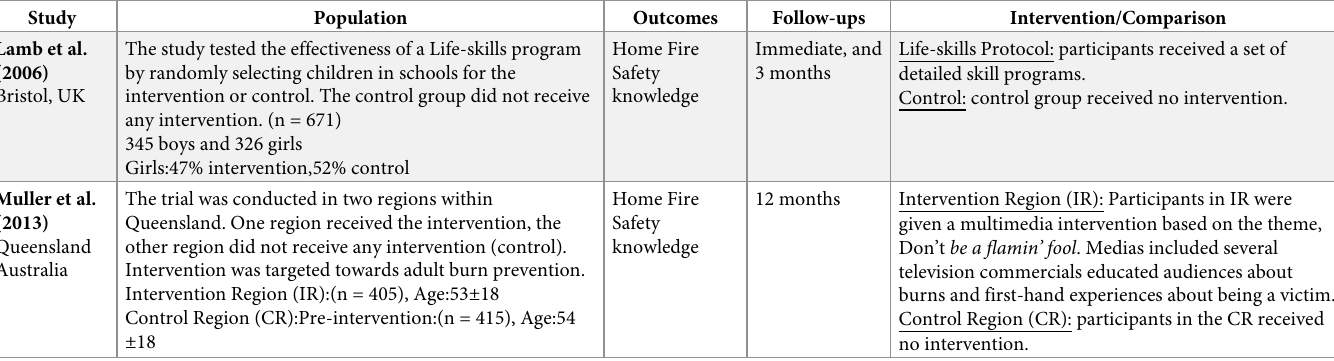
Table 2. Study characteristics of the included prospective cohort studies.